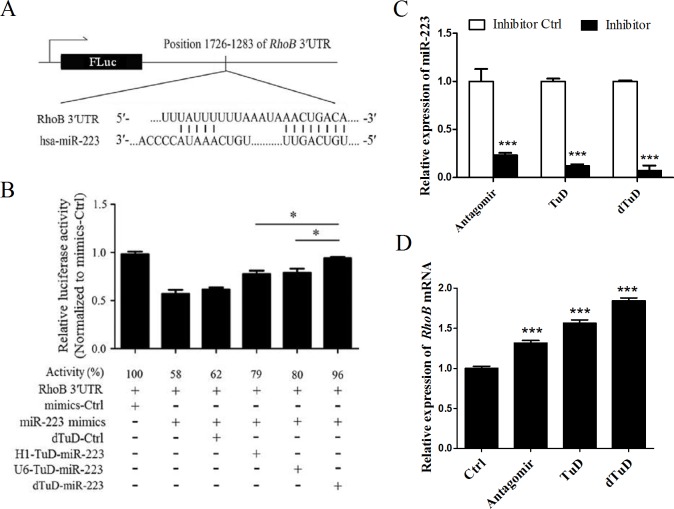
The inhibitory effect on miR-223 activity by dTuD-miR-223.(A) Schematic representation of 3′UTR luciferase reporter plasmid in which the 3′UTR of RhoB contained the binding sites of miR-233 (1726–1283 bp from 5′end) was fused to the 3′end of Firefly Luciferase (FLuc) after stop codon. (B) Dual-luciferase assay in 293A cells co-transfected with multiple plasmids as indicated. H1-TuD-miR-223 and U6-TuD-miR-223 represent the modified dTuD vector harboring a single TuD-miR-223 expression cassette driven by H1 and U6 promoter, respectively. After performing dual luciferase assay, the ratio FLuc/Renilla Luc (RLuc) was normalized to that of dTuD-Ctrl. (C) Expression level of miR-223 or (D) RhoB mRNA in 293A cells transfected with antagomir, TuD or dTuD against miR-233. Data were represented as the mean ± SD (n = 3). * p < 0.05, *** p < 0.001.